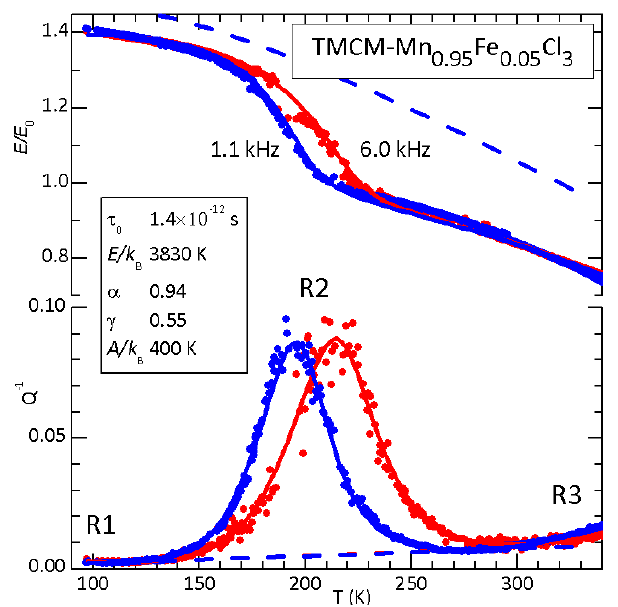
Figure 10. Global fit (solid lines) of the anelastic spectra of TMCM-Mn 0.95 Fe 0.05 Cl 3 measured during cooling, with the same set of parameters for all frequencies, as indicated in the legend and text. The dashed lines are the backgrounds obtained setting the amplitudes of R1–R3 to